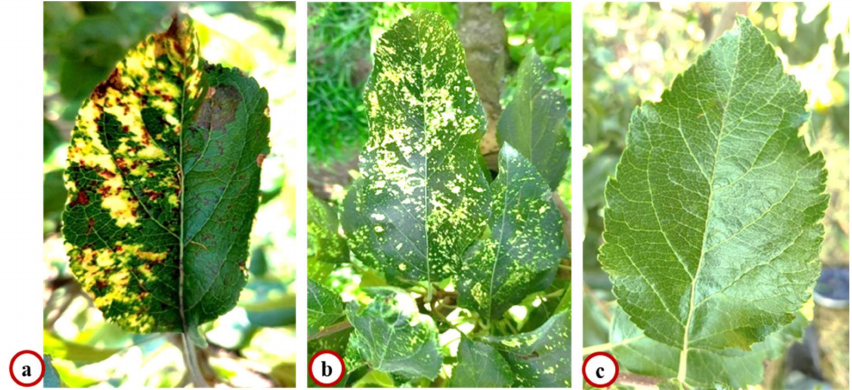
Figure 1. Symptoms of mosaic and necrosis on cultivar Oregon Spur ( a ); symptoms of mosaic randomly distributed on cultivar Golden Delicious ( b ); and asymptomatic cultivar Red Fuji bearing no symptom of either mosaic or necrosis ( c